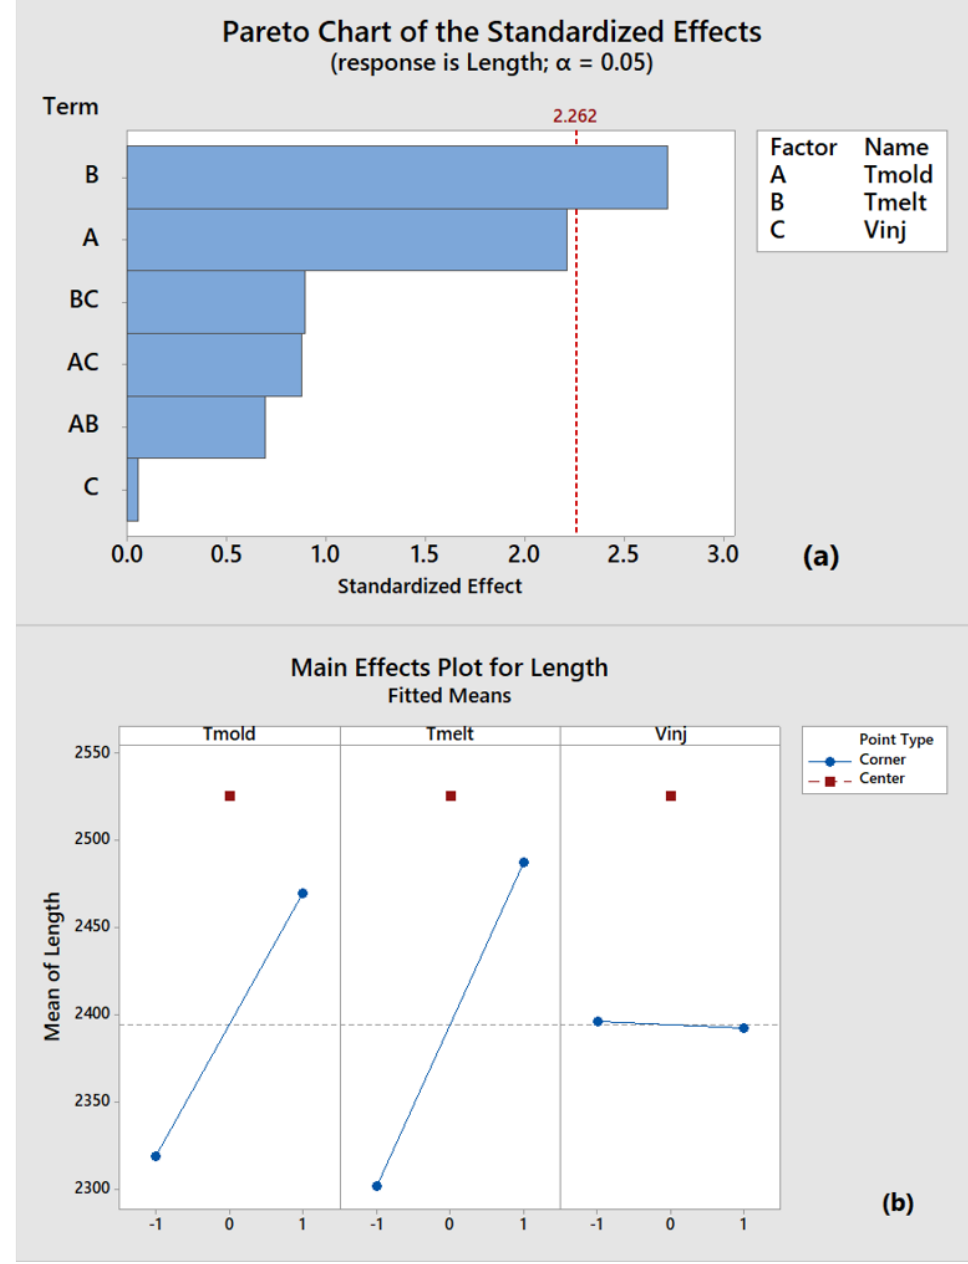
Figure 10. ( a ) Pareto chart and ( b ) main-effect plots of process parameters by considering length as quality index. quality